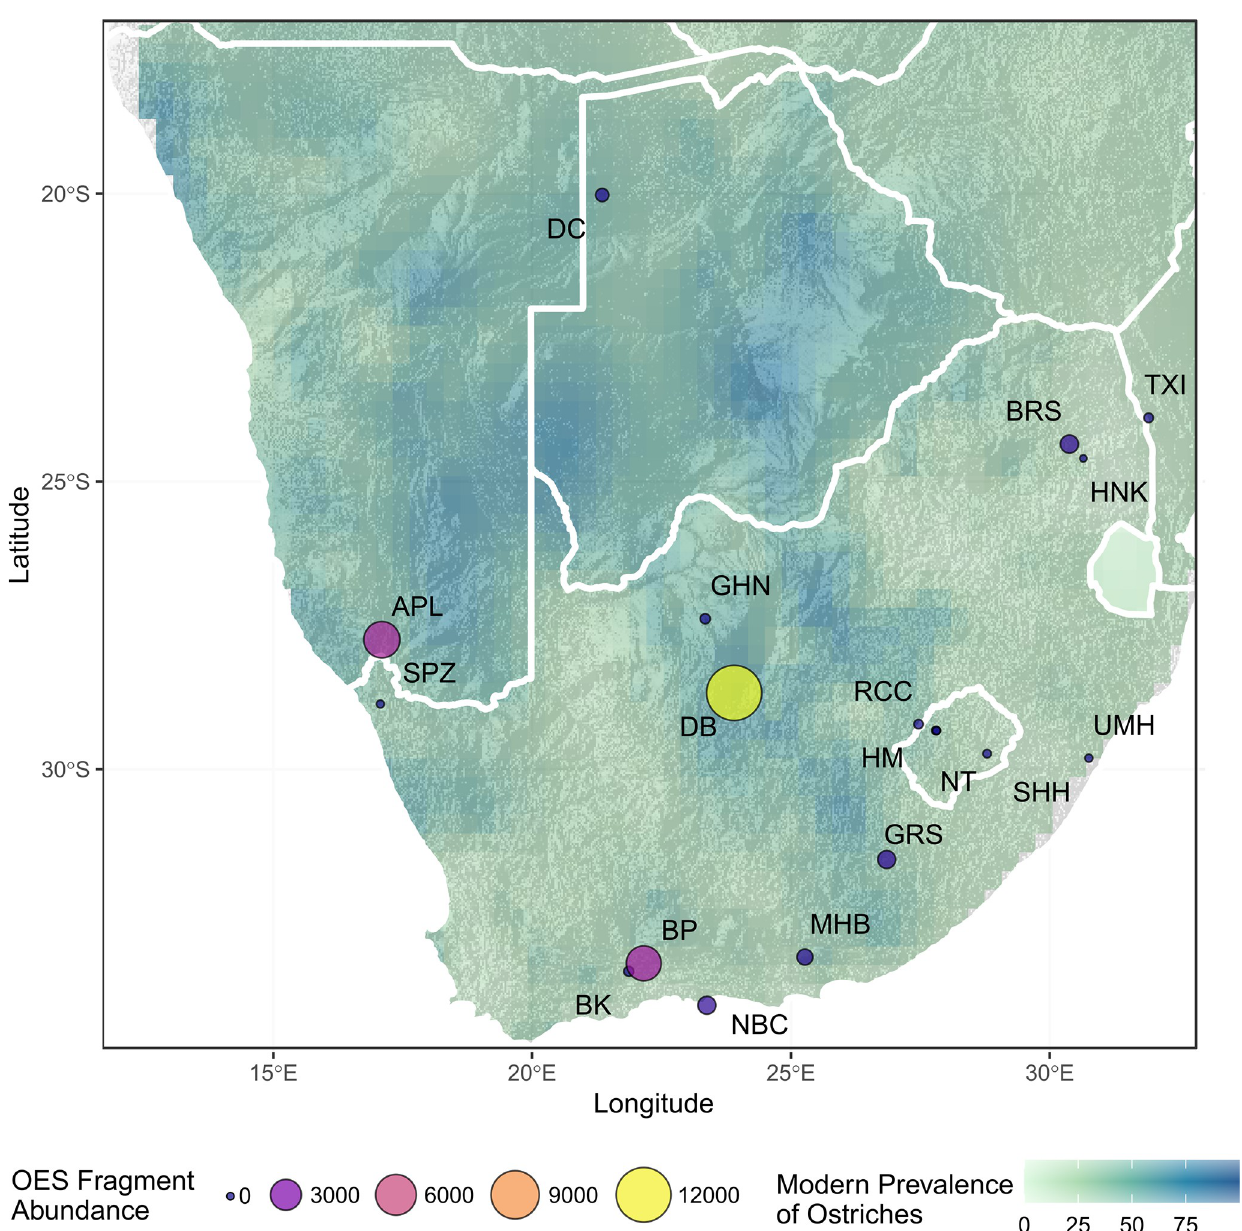
Fig 7. Map of southern Africa showing archaeological sites dated to MIS 2 that have OES bead assemblages. OES fragment counts for sites, overlaid on a map of modern ostrich prevalence based on South African Bird Atlas Project 2 data [60]. BK–Buffelskloof, BP–Boomplaas, NBC–Nelson Bay Cave, MHB- Melkhoutboom, GRS—Grassridge Rockshelter, NT–Ntloana Tsoana, RCC–Rose Cottage Cave, HM—Ha Makotoko, SHH–Sehonghong, UMH– Umhlatuzana, BRS–Bushmans Rockshelter, HNK—Heuningneskrans, TXI—Txina Txina, GHN–Ga-Mohana Hill North, DB—Dikbosch, DC—Drotsky’s Cave (Gcwihaba Cave), APL—Apollo 11,